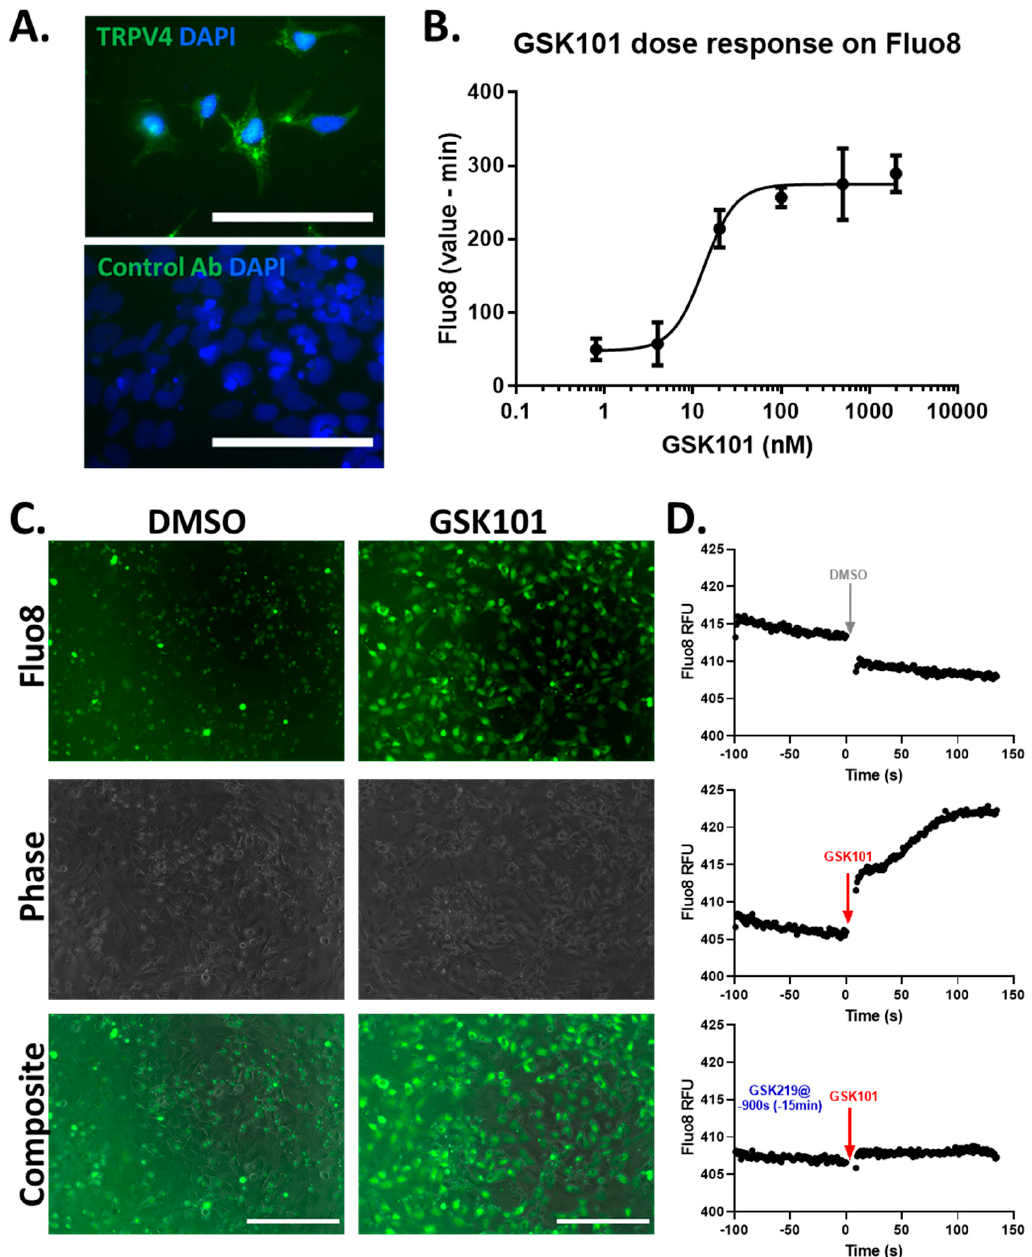
Figure 1. TRPV4 is expressed and can be activated in TC28a2 chondrocytes. ( A ) Immunostaining for TRPV4 in TC28a2 chondrocytes, using anti-TRPV4 antibody and DAPI nuclear stain. Scale bar represents 100 µm. ( B ) Dose response of GSK101 on Fluo8 fluorescence 15 min post stimulation. ( C ) Fluorescence imaging of Fluo8-loaded TC28a2 cells 15 min post stimulation with 100 nM GSK101 or DMSO control. Scale bar represents 200 µm. ( D ) Representative traces of Fluo8 fluorescence following DMSO (upper), 100 nM GSK101 stimulation (middle) or 100 nM GSK101 stimulation in cells pre-incubated with 500 nM GSK219 (lower) for 15 min. Data representative of three independent experiments.